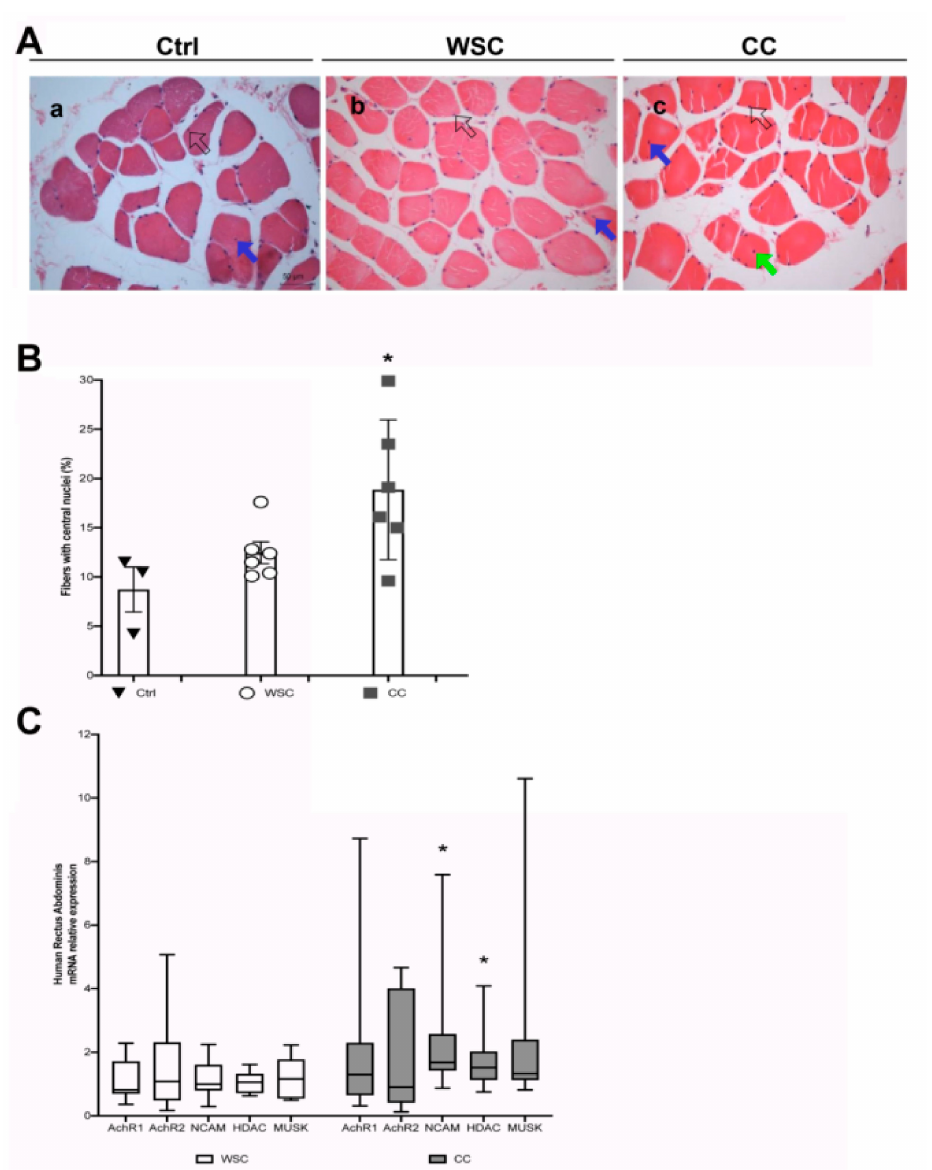
Figure 4. An increased number of central nuclei in the human Rectus Abdominis fibers is associated with cachexia and denervation markers. ( A ) Representative images showing H&E staining of cross sections from the RA muscle of patients without cancer ( a , Ctrl), Weight-Stable Cancer patients ( b , WSC) and Cancer Cachexia patients ( c , CC). Central nuclei are indicated by blue or green arrows (in the first case the nucleus is just displaced from the subsarcolemmal position, while in the second case it is closer to the center of the fiber); peripheral (i.e. normal) myonuclei are indicated by open arrows. Scale bar is 50 µ m. ( B ) Percentage of fibers with central nuclei in muscle cross-sections of Ctrl, WSC and CC patients (a randomly chosen subset of the patients in Table 1). The three groups showed significant di ff erences in the number of fibers with central myonuclei (F = 4.93; df = 2; p = 0.025 by ANOVA; * p < 0.05 by Tukey’s HSD test, used as a post-hoc test for CC vs Ctrl). Data are presented as mean +/ - SEM, n = 3–6 for each group. ( C ) Q-PCR analysis on muscle from the RA of WSC (n = 10) and CC (n = 13) patients for denervation markers as indicated. Data are presented as box-and-whisker plot, showing the median +/ - 10–90 percentile range, and analyzed by using Wilcoxon-Mann-Whitney test; * p <